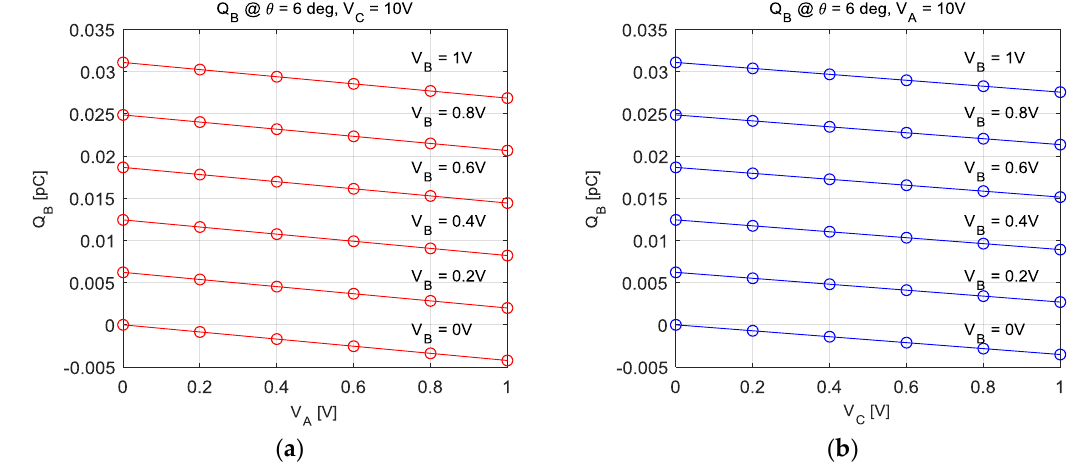
Figure 10. The amount of electric charges on the rotor when supplying ( a ) V A and V C , ( b ) V B and V C .